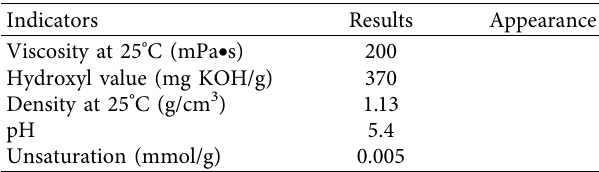
Table 2: Technical indicators of combined polyether